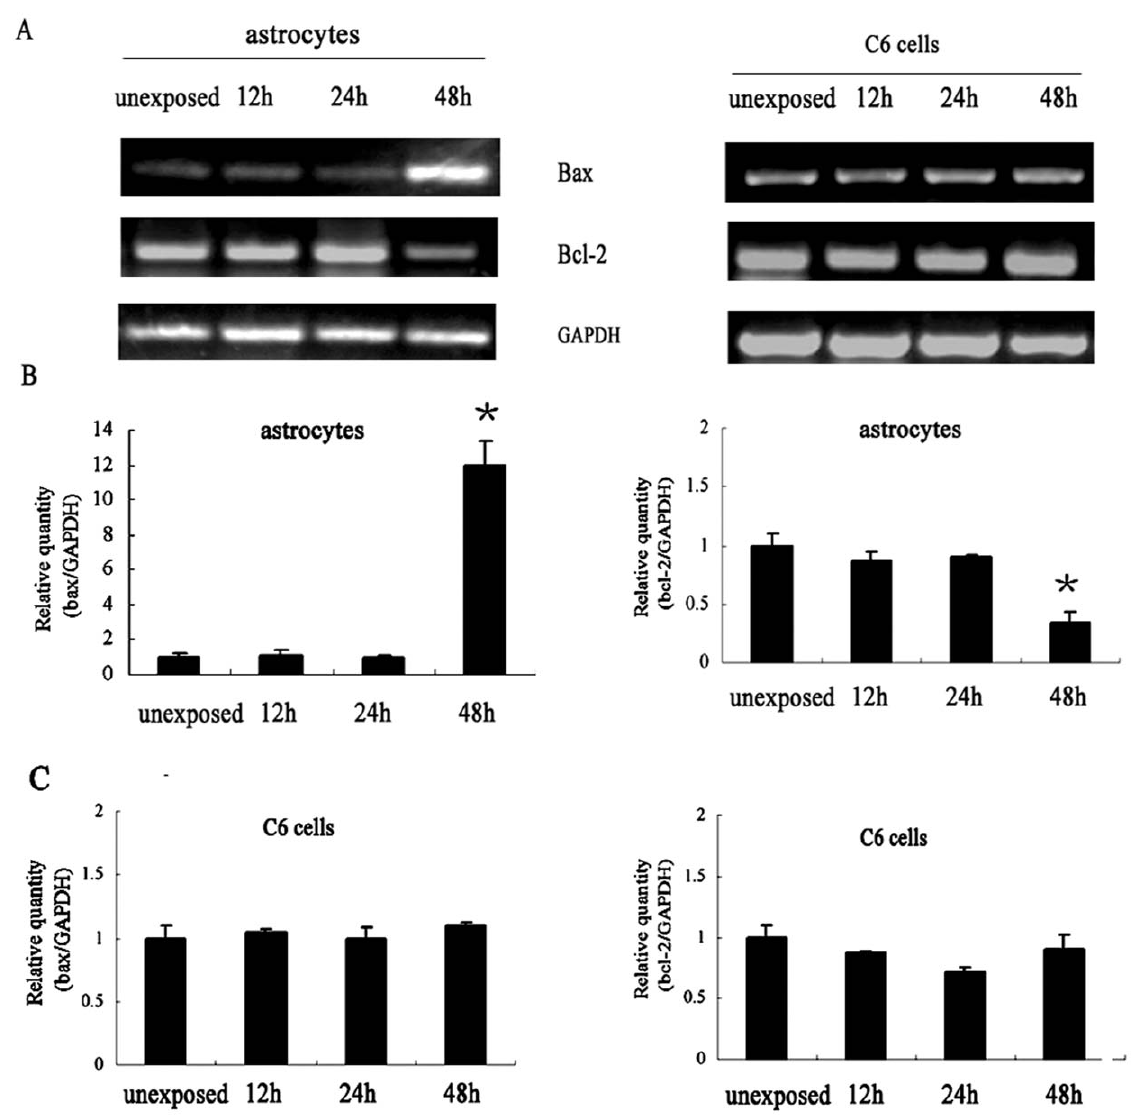
Figure 5. The expression of apoptotic genes in glial cells after EMF exposure. (A) RT-PCR analysis for the expression of bcl-2, bax in sham- or RF-exposed cells. A significant down-regulation of bcl-2 mRNA levels and up-regulation of bax mRNA levels were detected in astrocytes after 48 h exposure (B). Real-time PCR analysis for the expression of bcl-2 , bax in sham- or RF-exposed cells. More than 12-fold increase of bax and 2-fold decrease of bcl-2 were detected in 48 h-exposed astrocytes. The average of the normalized ratio of the target gene/GAPDH was calculated. The data represent the mean 6 SEM from three experiments. *P , 0.05 as compared with unexposed groups.